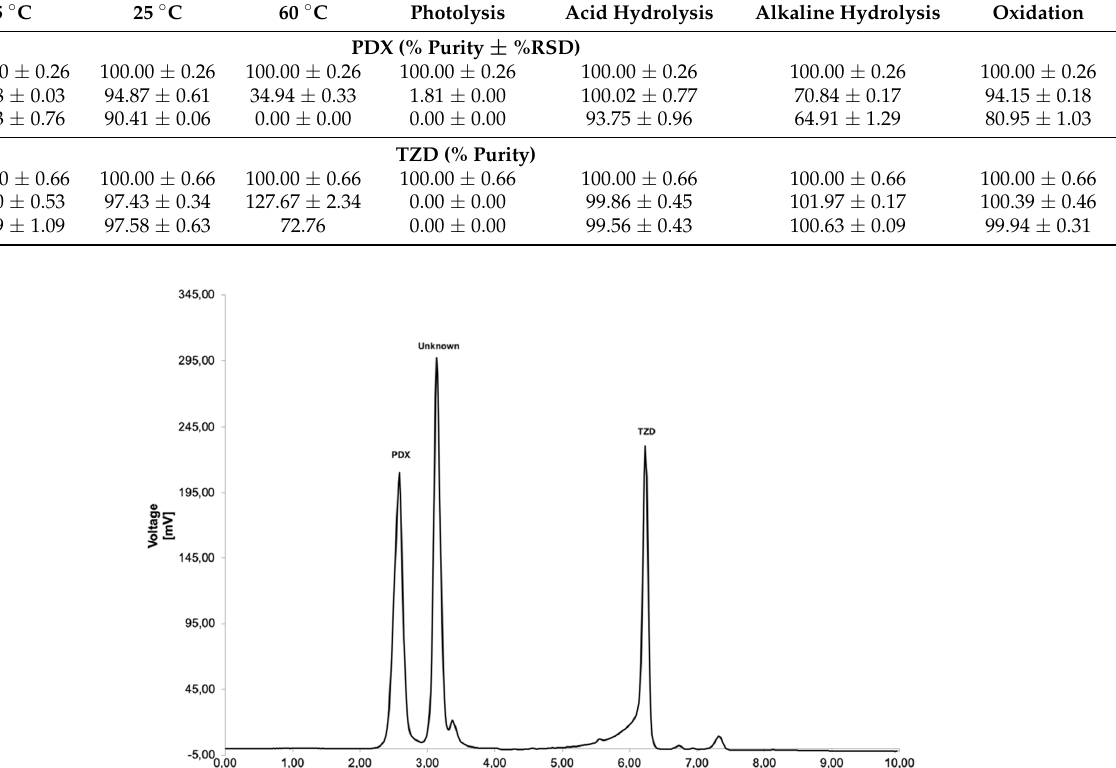
Figure 4. Chromatogram obtained with a solution containing 200 µ g/mL of both PDX and TZD after exposure to a storage temperature of 60.0 °C for a period of 24 h.